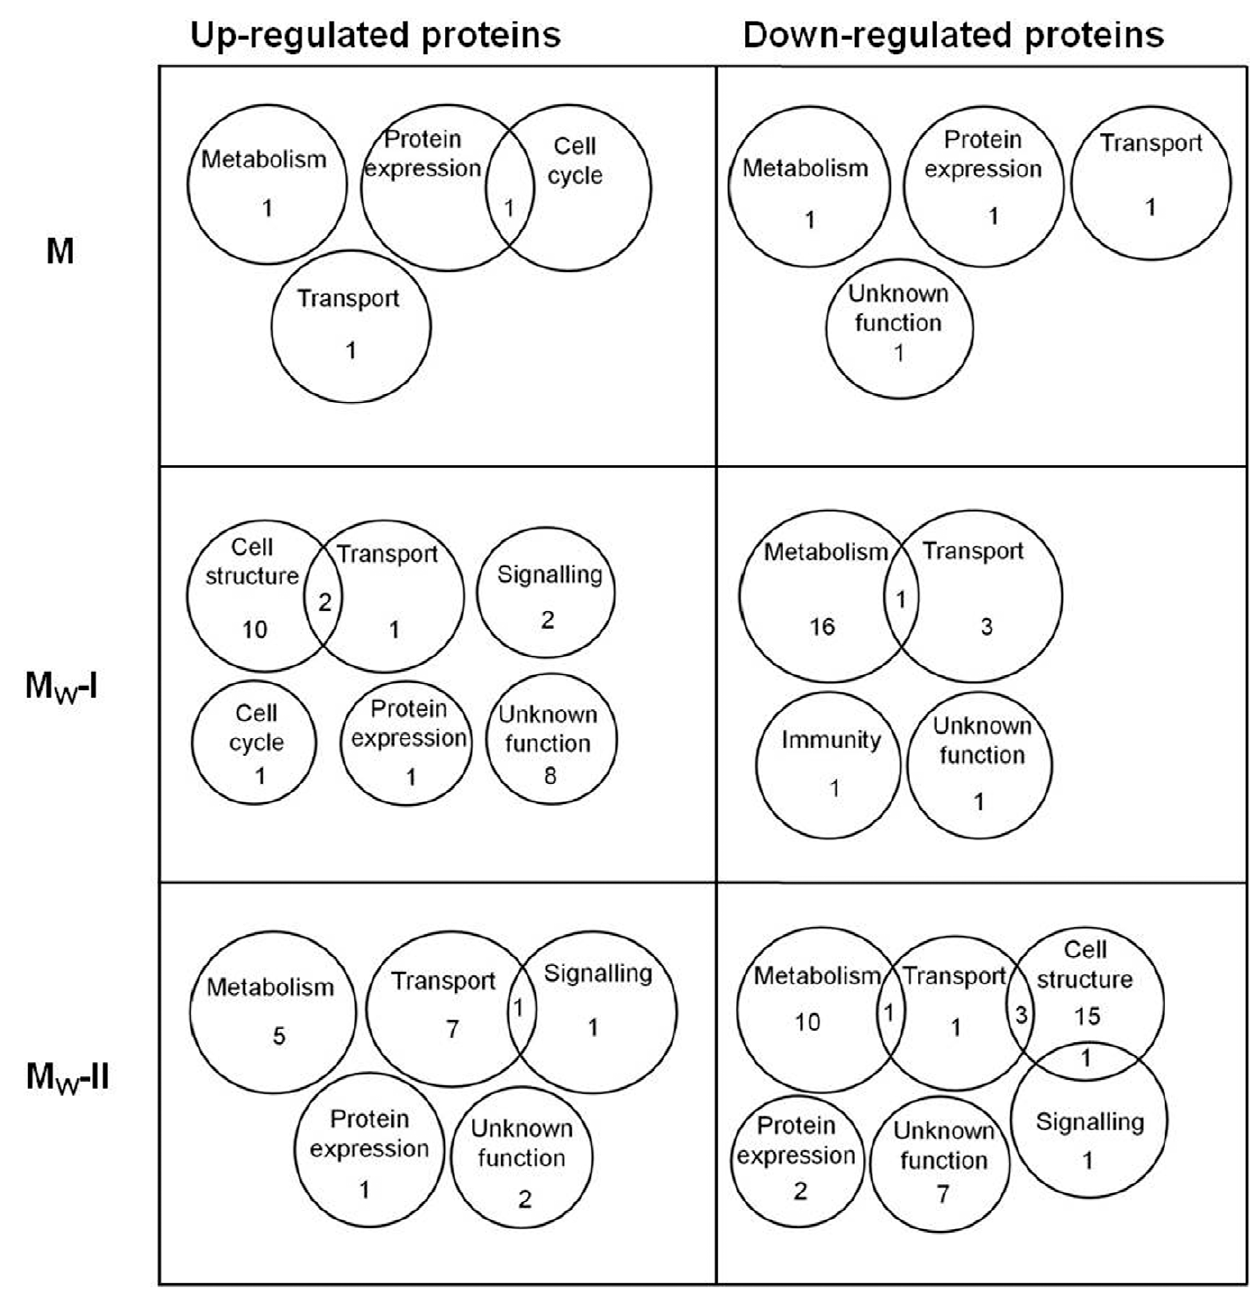
Figure 5. Venn diagrams showing the distribution of myocardial proteins in the mitochondria-enriched fraction altered by morphine treatment and withdrawal. Numbers in the individual circles or sectors refer to the number of altered proteins which were determined in the MT-enriched fraction isolated from the left ventricles of morphine-treated (M) and morphine-withdrawn for 3 days (M W -I) or 6 days (M W -II) rats. These proteins were arranged according to their function into 16 groups.